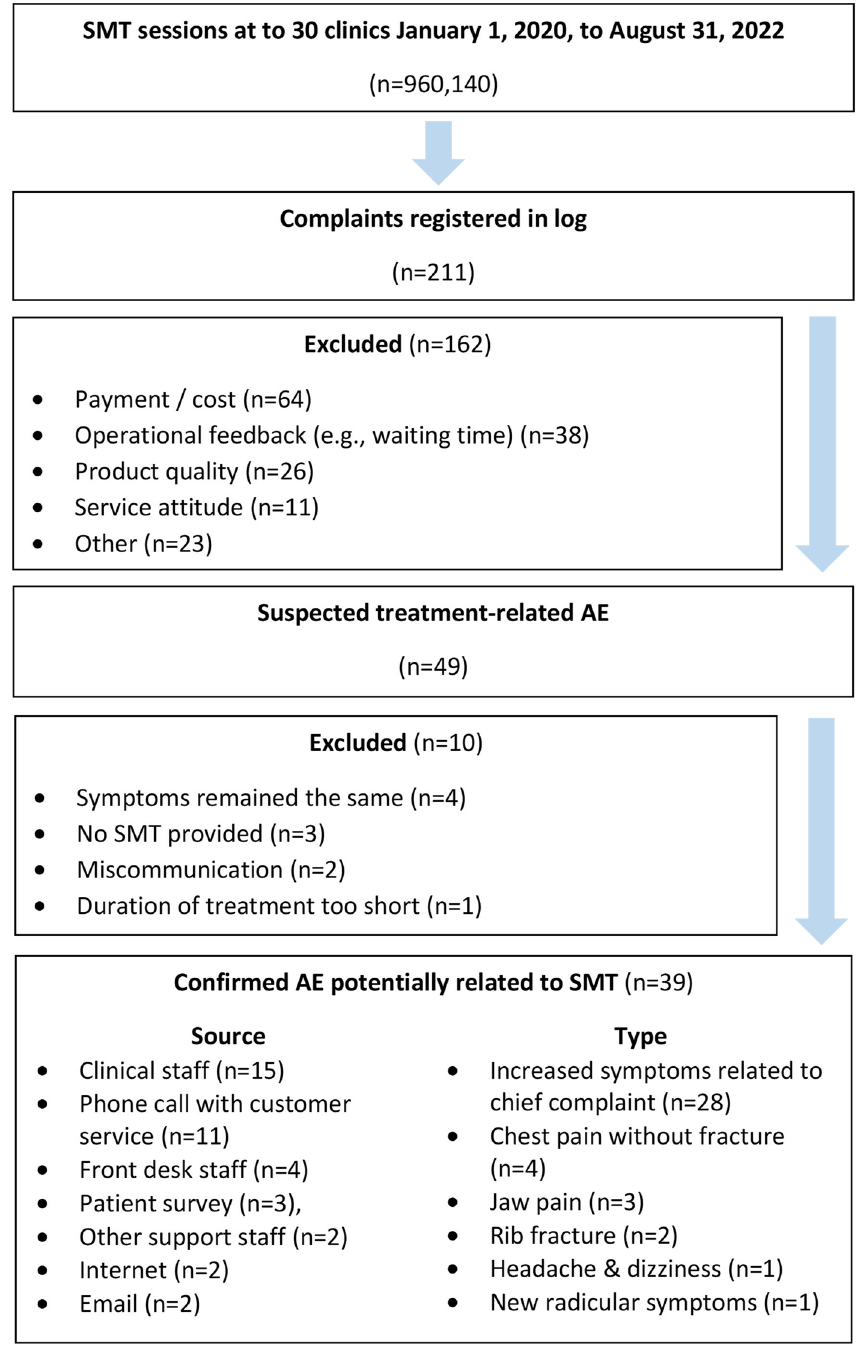
Figure 1. Identification of patients with adverse events related to spinal manipulative therapy. Abbreviations: adverse event (AE), spinal manipulative therapy